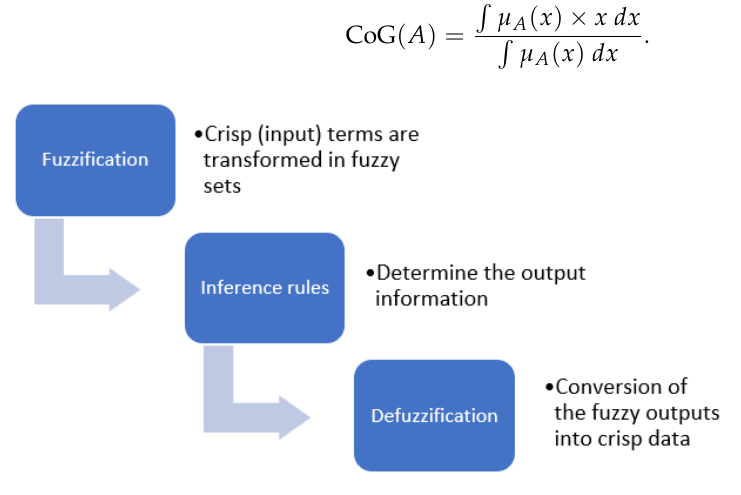
Figure 1. The fuzzy logic process.